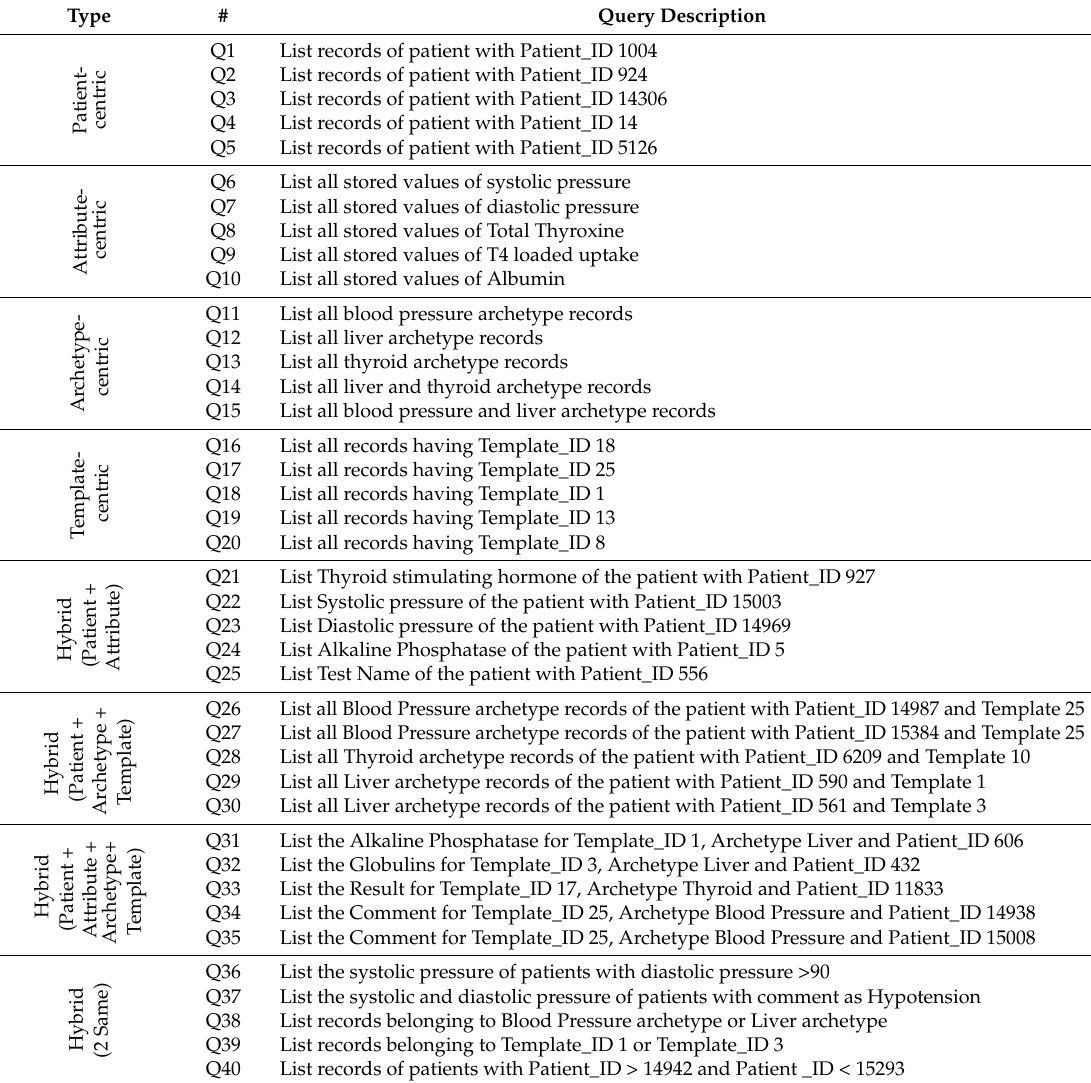
Table A2. Query set for experiment.